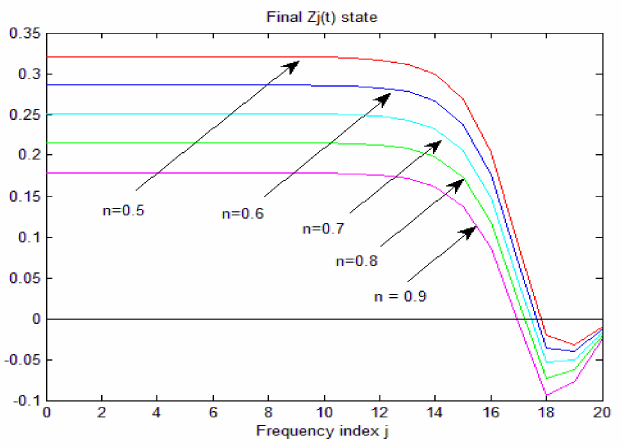
Figure 6. Distributed z ( ω , T ) final free